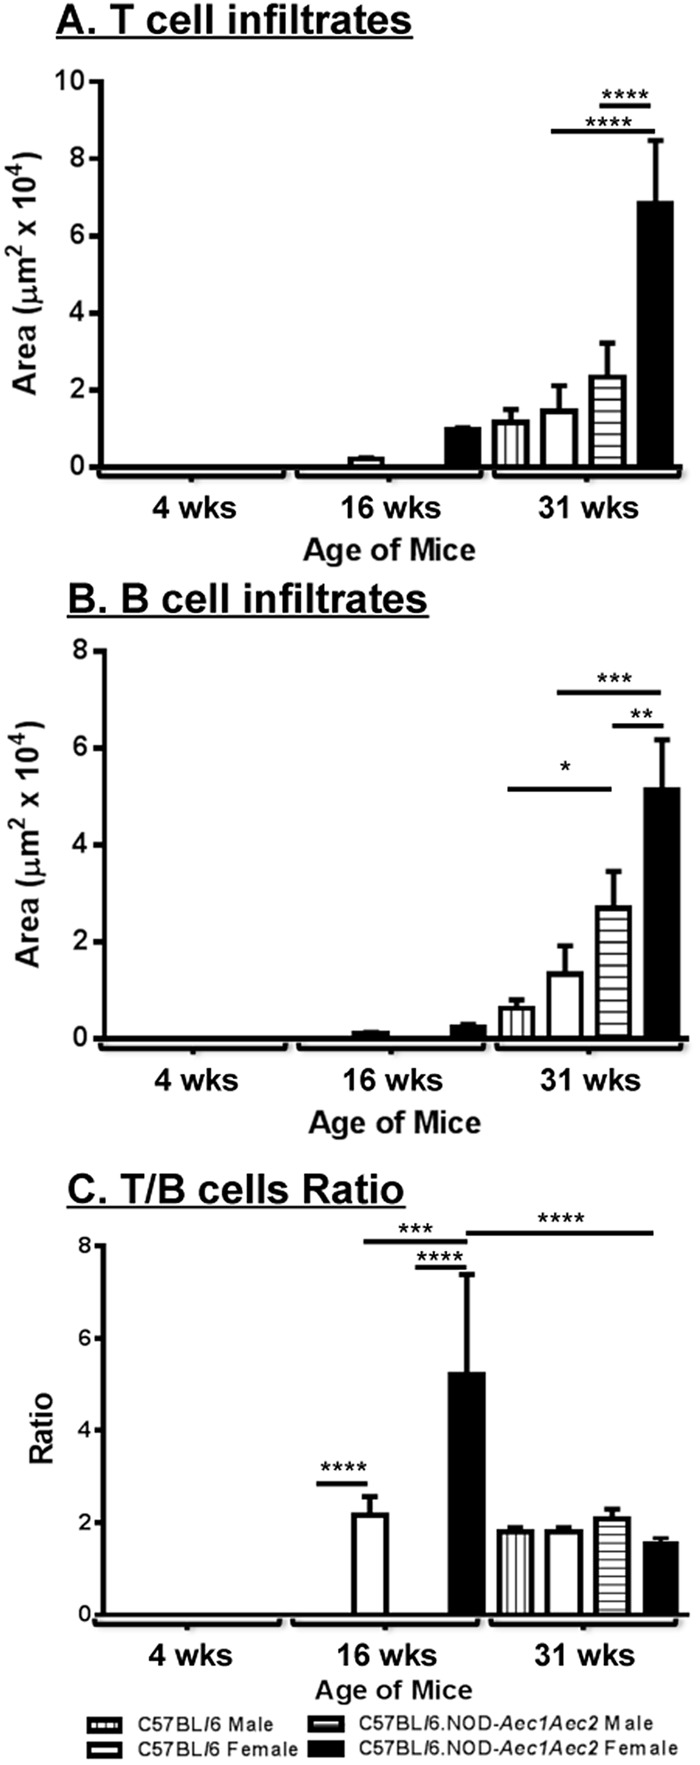
Degree of CD3+ T cells and B220+ B cells infiltration in salivary glands. Based on immunofluorescent staining for CD3/B220 in male and female C57BL/6 and C57BL/6J.NOD-Aec1Aec2 presented in Fig. 3, measurement of areas using densitometrical analysis was calculated using Nikon Elements software with the percentage of threshold events in ROI function. The mean±s.e.m. was calculated for both the B and T cells (A,B), whereas the mean of the ratio of T:B cells was calculated (C); the significance for each was calculated by two-way ANOVA. Error bars indicate s.e.m. with *P<0.05, **P<0.01, ***P<0.001, ****P<0.0001.